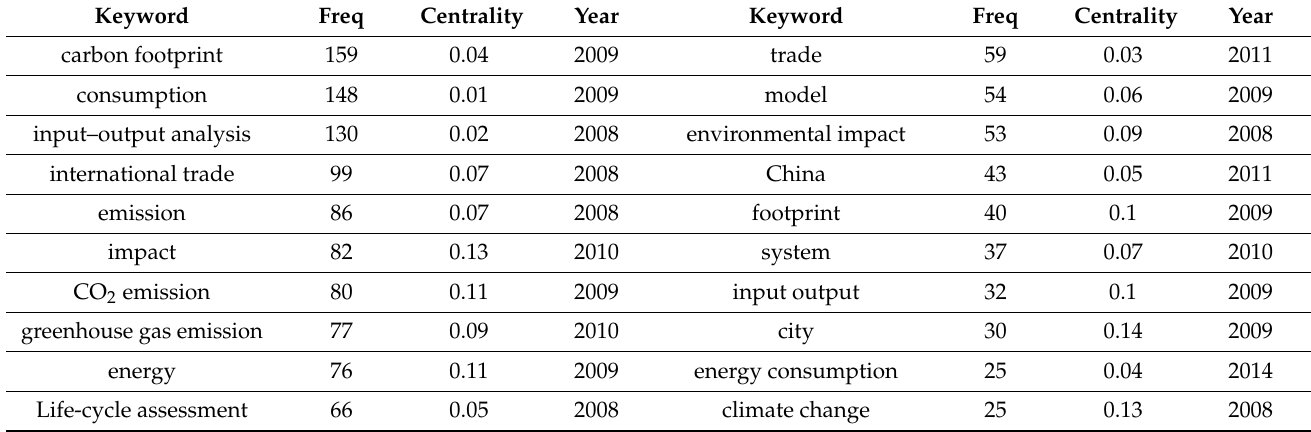
Table 5. The top 20 high-frequency